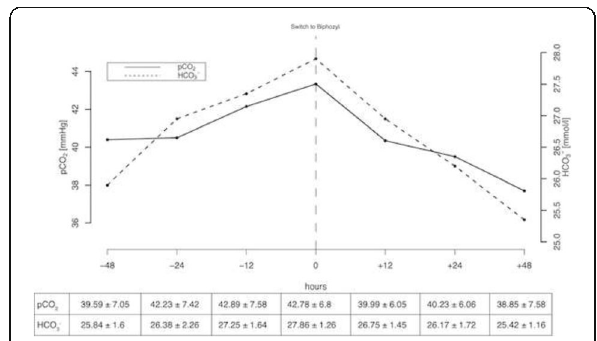
Fig. 2 (abstract 0303). Time course of pCO2 and